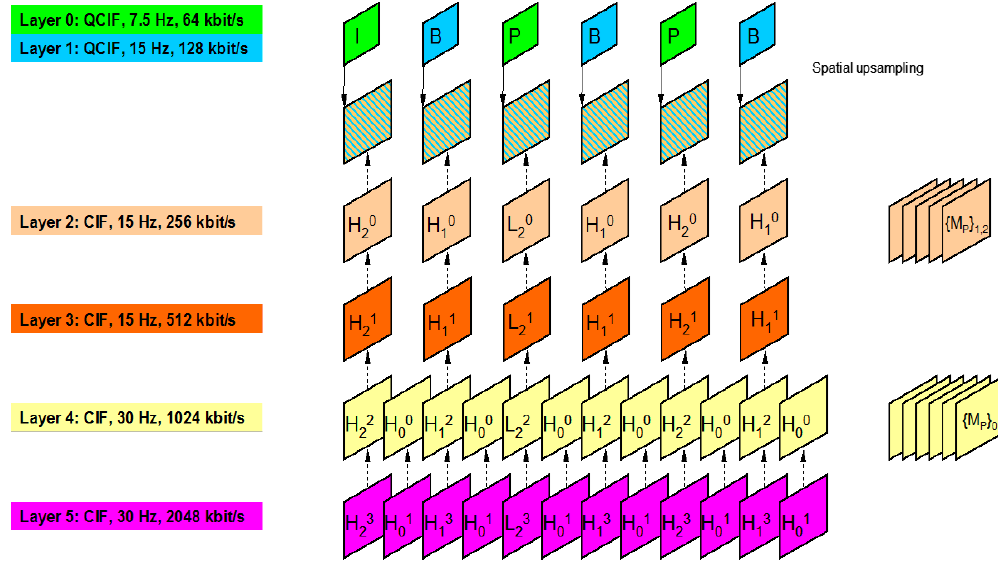
Figure 1. Temporal, spatial and quality scalability of scalable video coding